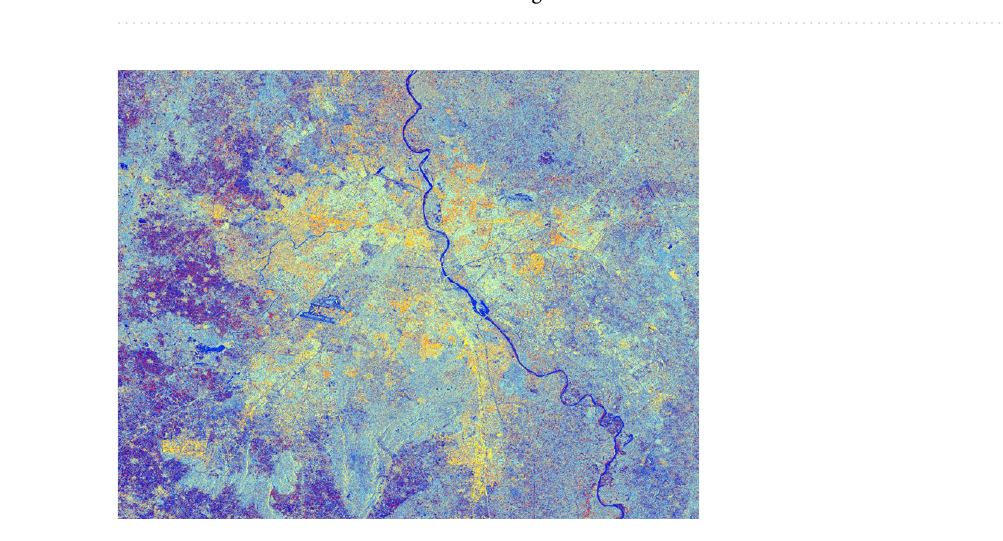
Figure 19. Colour composite image (Red: VV, Green: VH, Blue: VH/VV) of the Sentinel-1 dual-polarization C-band data in with a window size of 15 and sigma value of 0.5.